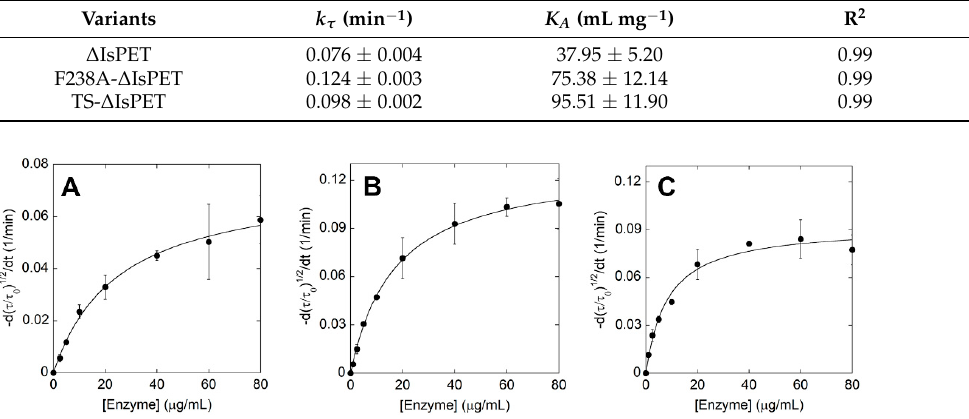
Figure 5. Kinetic analysis of ∆ IsPET variants on PET nanoparticles. Plot of initial rates determined at increasing concentrations of ∆ IsPET ( A ), F238A- ∆ IsPET ( B ), and TS- ∆ IsPET ( C ); see Figure S8. Experimental data points, shown as circles, were fitted based on Equation (2). Kinetic measures were performed in triplicate.